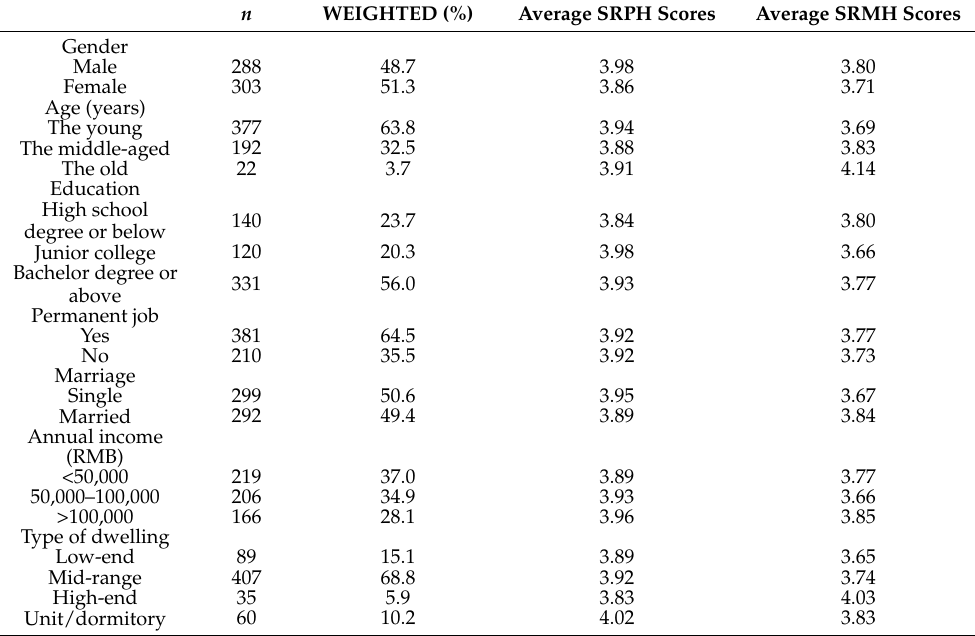
Table 1. Description of variables.